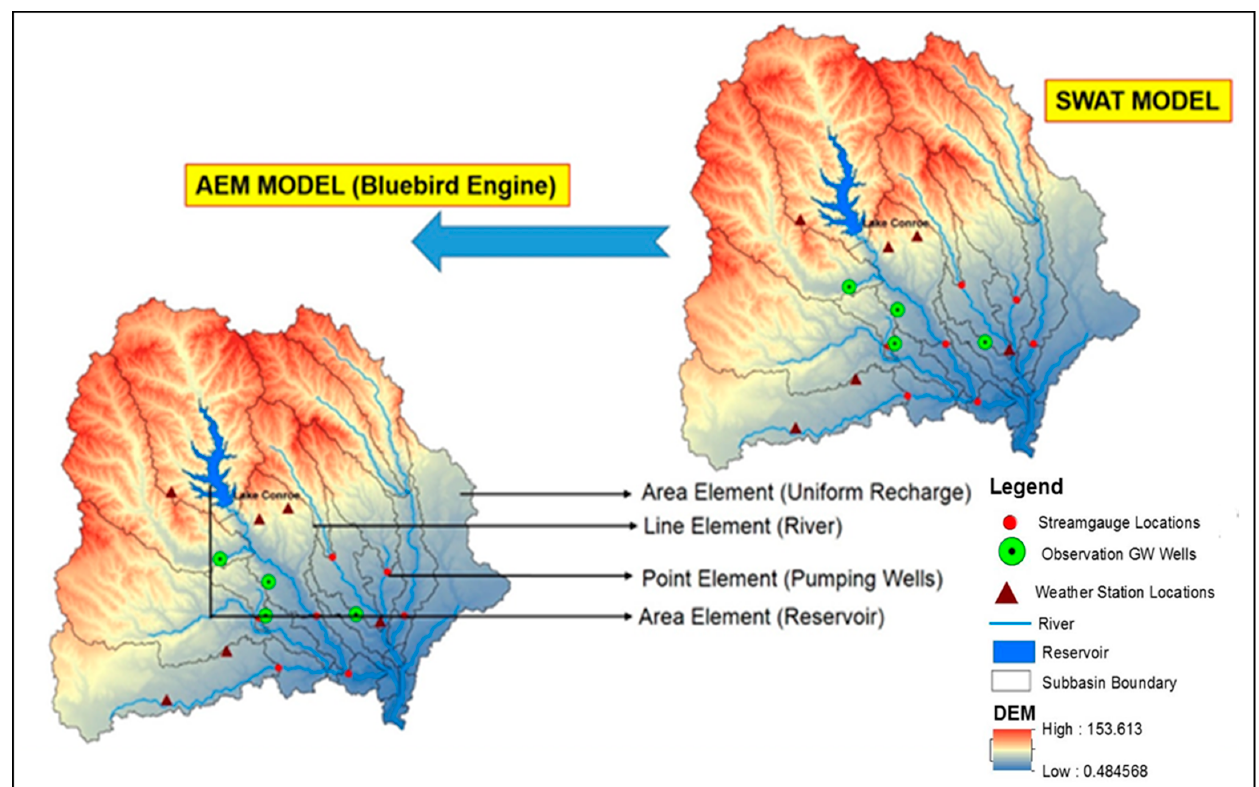
Figure 4. Conversion of HRU/Subbasin to Analytic Elements.